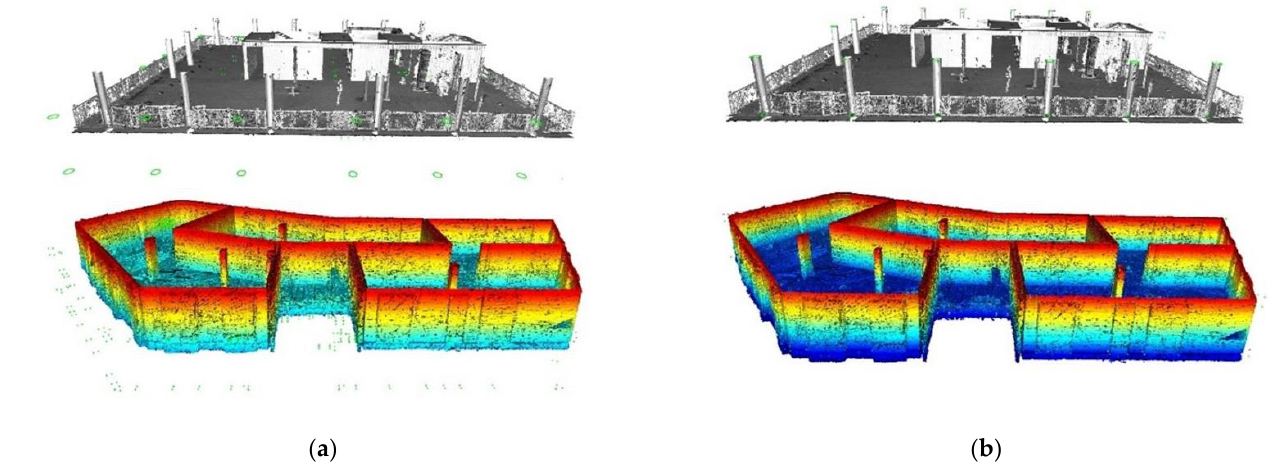
Figure 10. Initial alignment: ( a ) source and target point cloud’s spatial location after conversion to zero origin, and ( b ) source and target point cloud’s spatial location after initial alignment using 3 reference points.